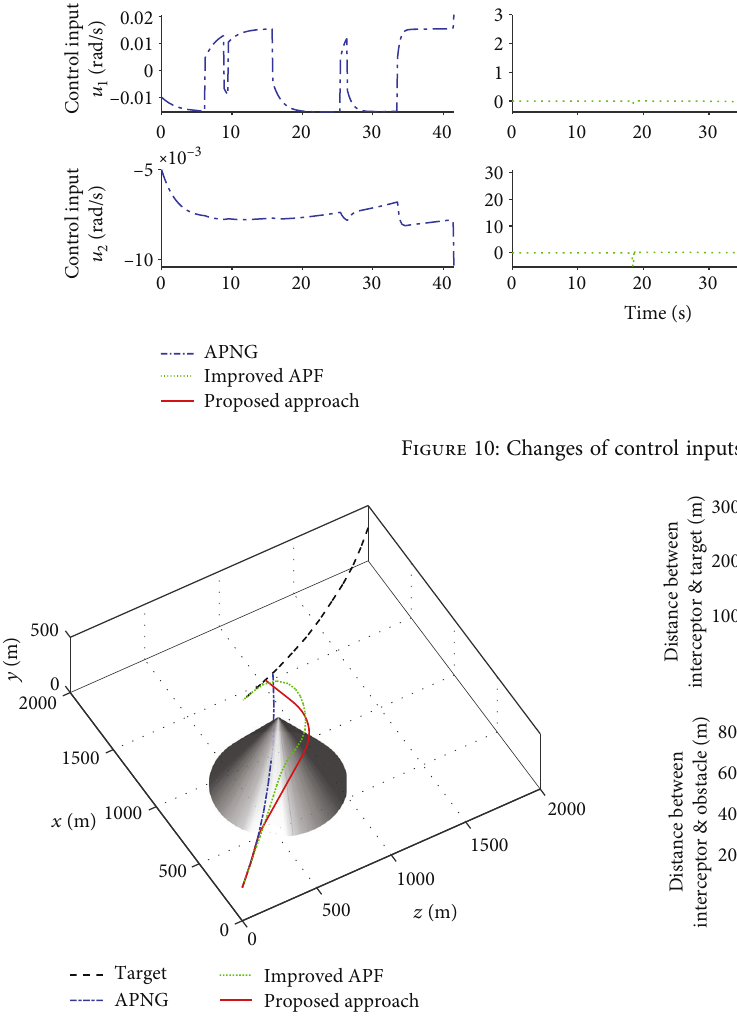
Figure 11: Flight trajectories of interceptor and target in case 2.